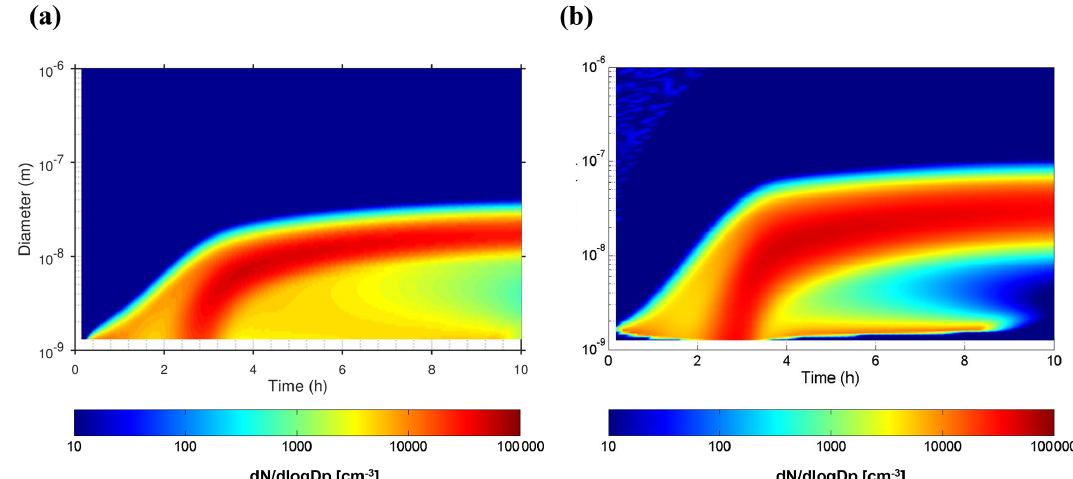
Figure 15. Evolution of the modelled particle number size distribution in a 10h simulation to compare the performance of the nucleation code M2018 in (a) MAFOR v2.0 to that in (b) AEROFOR. New particles were inserted at 1.0 and 1.5nm diameter in MAFOR and AEROFOR, respectively. The first particle formation after 15min is due to ion-induced nucleation, and the main particle burst after 2h is due to neutral nucleation. Final mean D p was 18 and 22nm, respectively, in MAFOR and AEROFOR simulations. Details on the configuration of the numerical experiment are given in Appendix